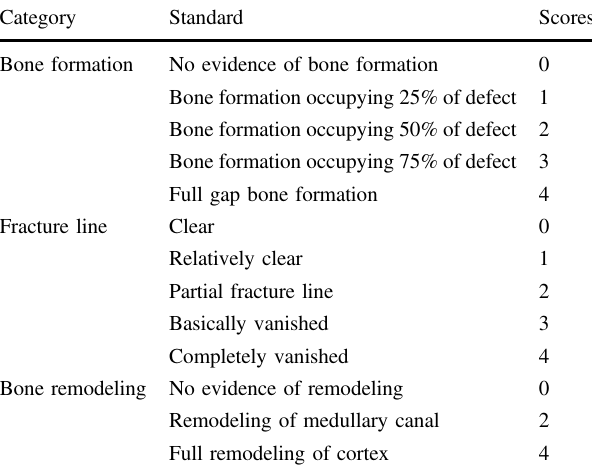
Table 1 Lane – sandhu radiographic scoring standard Category